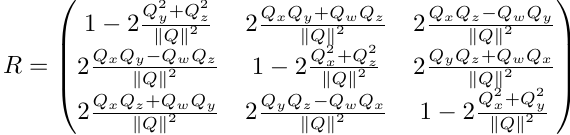
Figure 9: Polyhedron triangulation.